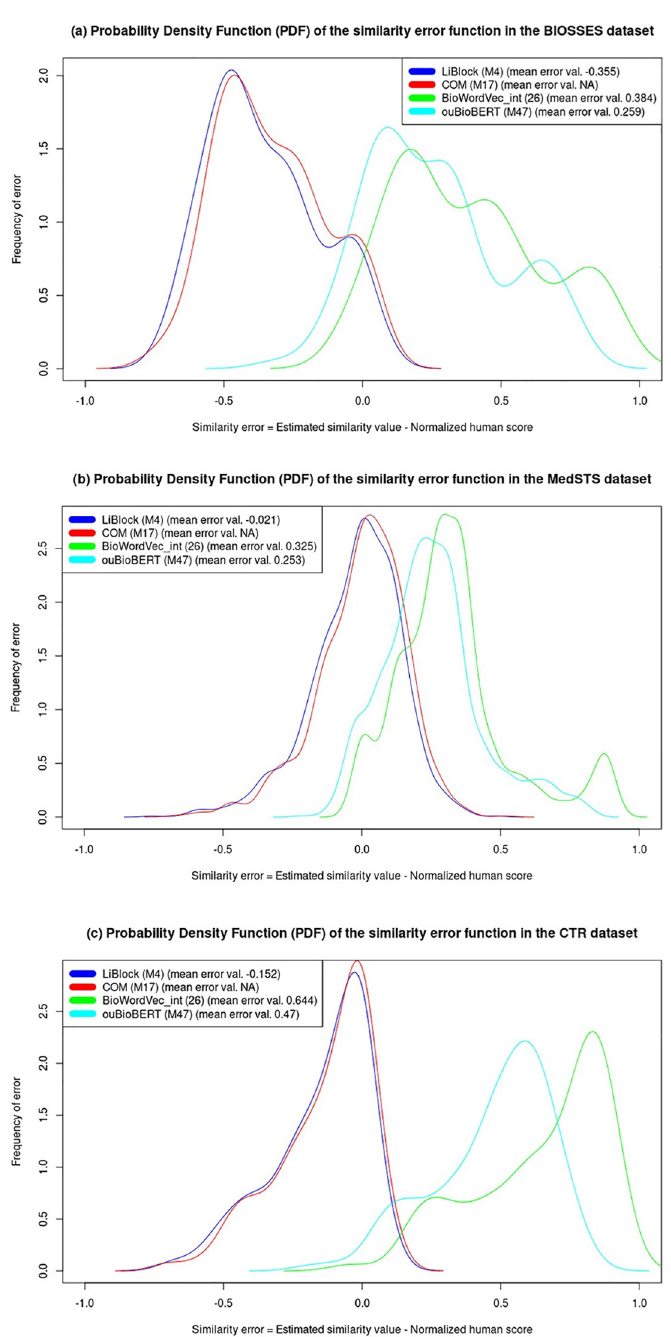
Fig 6. Probability Density Function (PDF) and mean value of the similarity error ( E performing methods in the evaluation of each dataset as follows: (a) BIOSSES, (b) MedSTS, and (c)